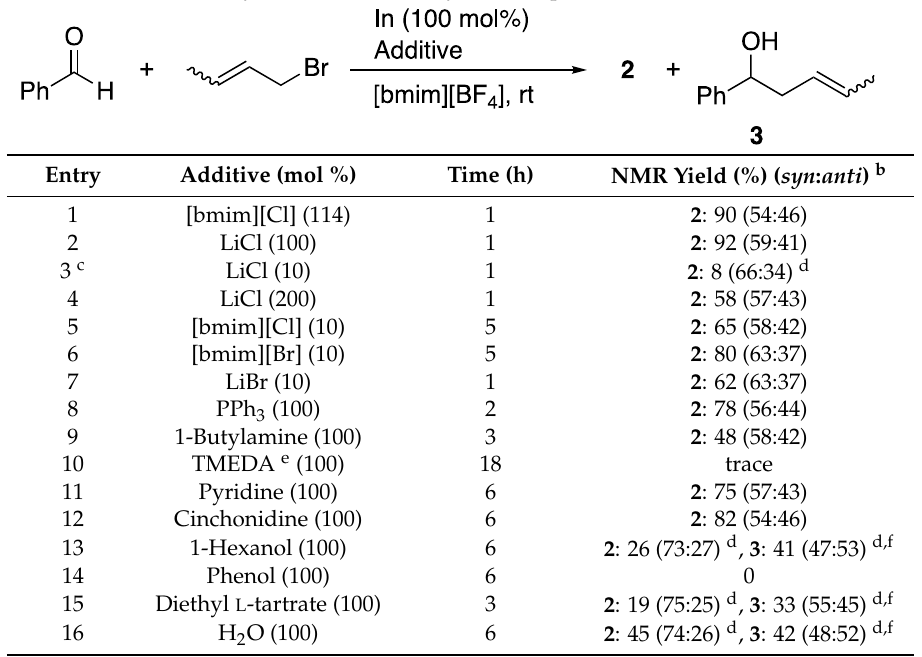
Table 4. Crotylation of benzaldehyde in the presence of additives a .